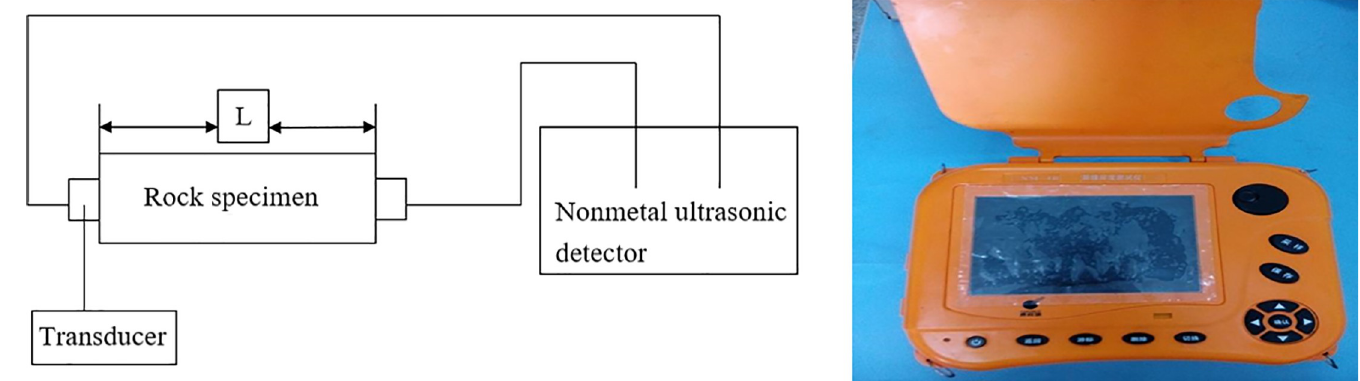
Fig 12. Rock acoustic measurement test and testing instrument.